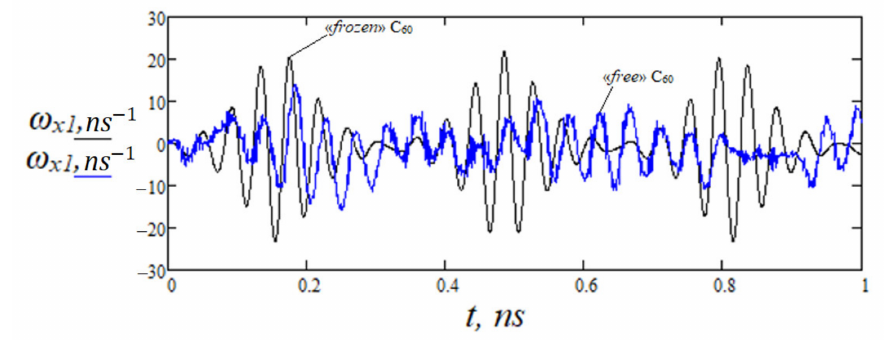
Figure 4. Comparison of rotations of two systems with free and “frozen” fullerenes.